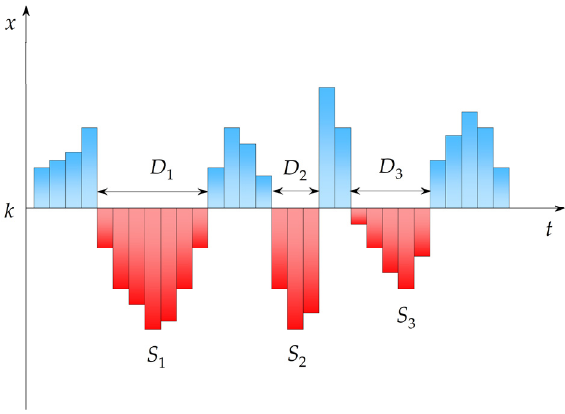
Figure 2. Schematic diagram of drought characteristics recognition process.